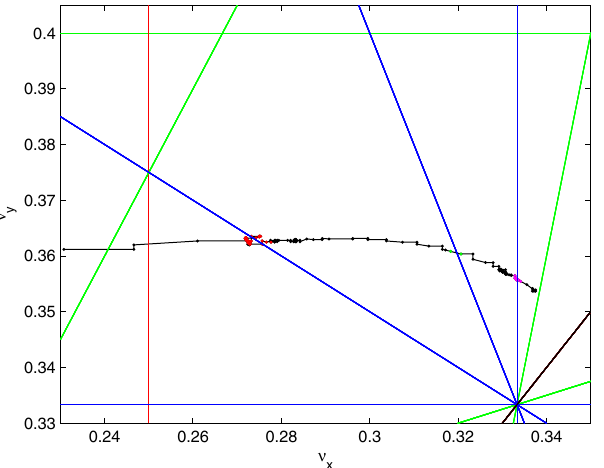
FIG. 9. Measured tune footprint during the sextupole optimi- zation. The color code corresponds to the data of Fig. 8.